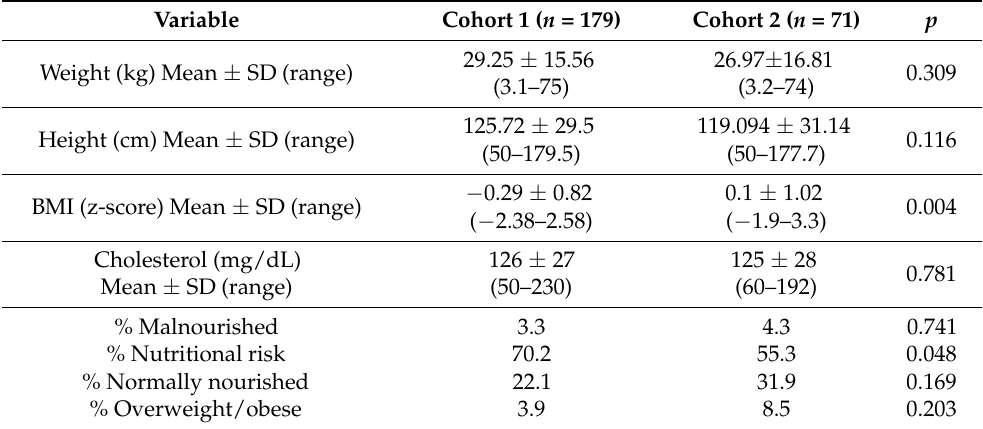
Patients in cohort 2 had higher BMI values and lower nutritional risk than those in cohort 1. However, no differences were observed in the percentage of undernourished (Table 3). Regarding vitamins A and E, no significant differences were observed between groups. Vitamin A serum levels: 39.15 vs 38.44 mcg/dL ( p = 0.727); vitamin E serum levels: